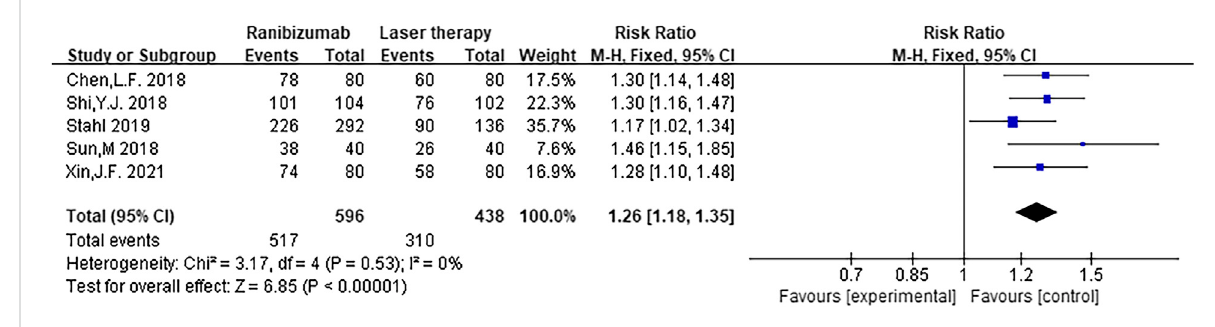
FIGURE 4 Forest plot: ranibizumab injection of retinopathy of prematurity (ROP) ef fi cacy compared to laser treatment.